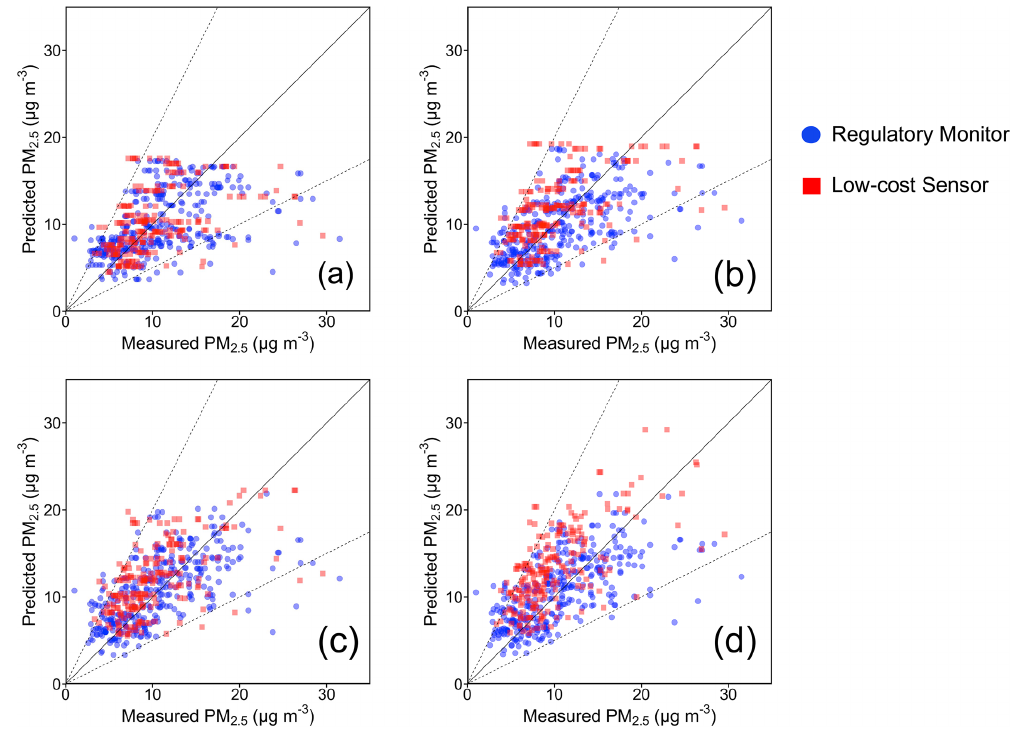
Figure 5. Comparison of daily average PMCAMx-v2.0-predicted concentrations of PM 2 . 5 with daily regulatory measurements and daily low-cost sensor measurements at (a) 36 × 36, (b) 12 × 12, (c) 4 × 4, and (d) 1km × 1km during February 2017. Table 3. Comparison of daily average PMCAMx-v2.0-predicted PM 2 . 5 concentrations during February and July 2017 with daily low-cost sensor (RAMP)